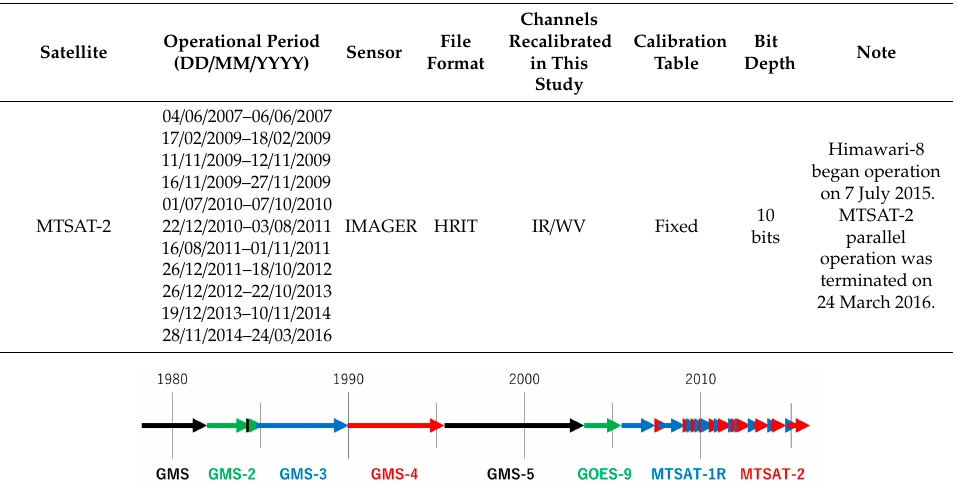
Figure 1. Graphical representation of operational periods of JMA’s historical geostationary satellites and sensors.